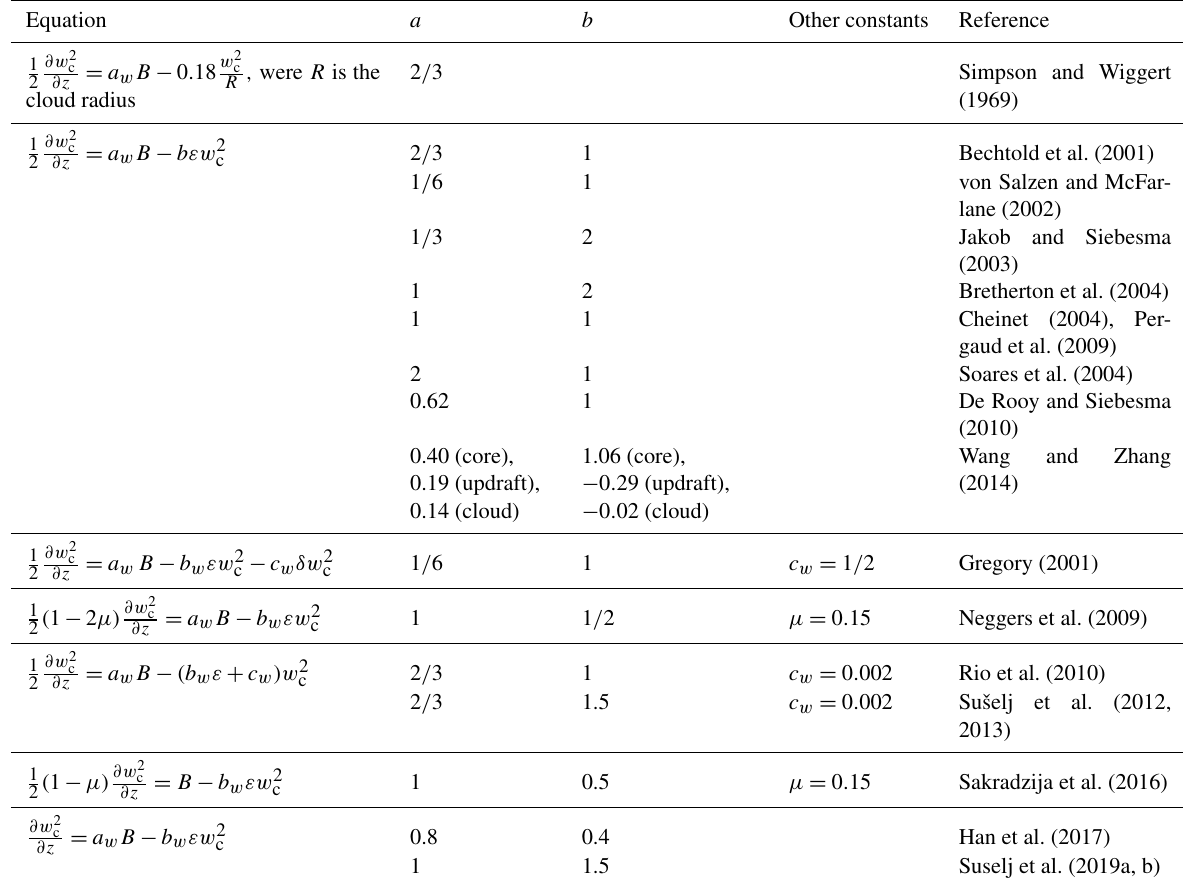
Table 1. A sample of values a w and b w used in Eq. (6). Based on de Roode et al. (2012). Equation a b Other